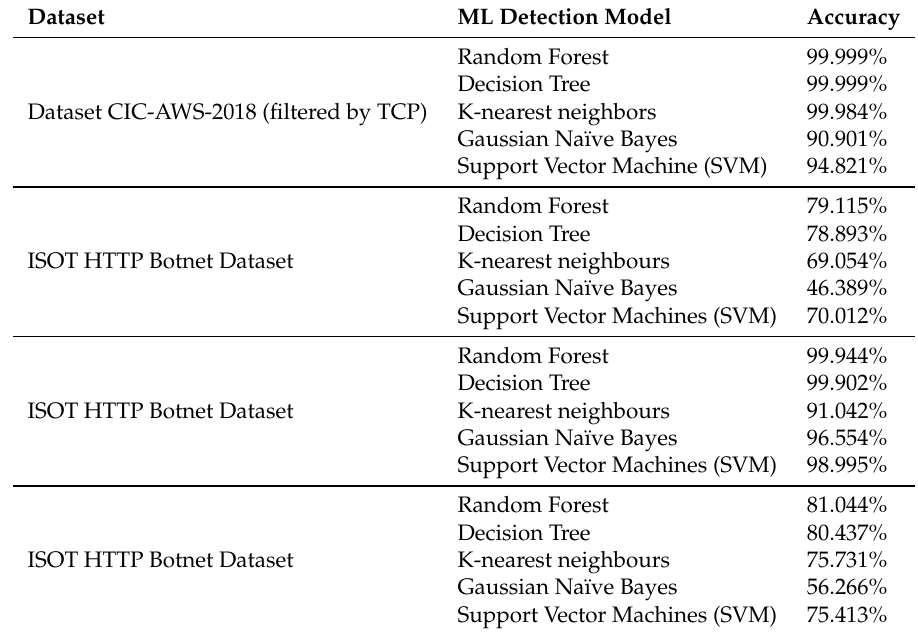
Table 8. Comparison between the CIC-AWS-2018 and ISOT HTTP Botnet detection models with GS.